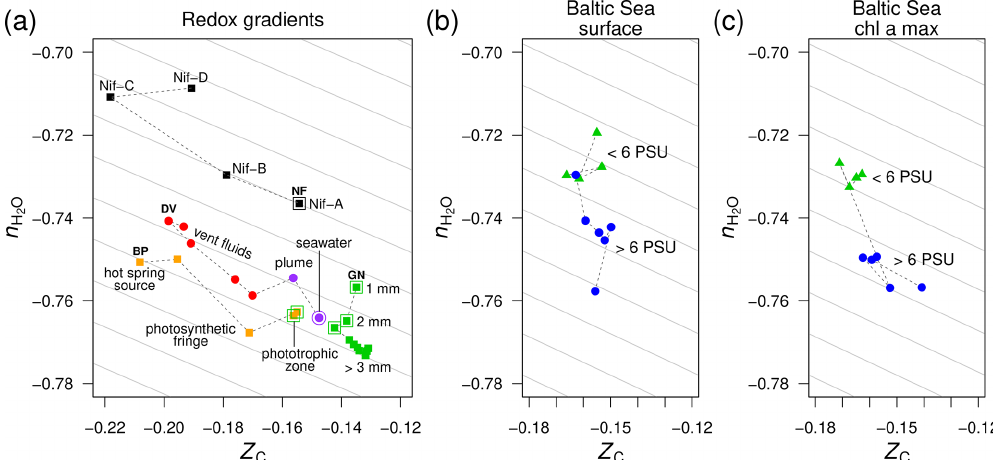
Figure 3. Compositional analysis of proteins in redox gradients and the Baltic Sea salinity gradient. (a) Redox gradients. Abbreviations and data sources: BP (Bison Pool hot spring; Havig et al., 2011; Swingley et al., 2012), DV (diffuse submarine vents; Reveillaud et al., 2016; Fortunato et al., 2018), GN (Guerrero Negro microbial mat; Kunin et al., 2008), and NF (nitrogenase-bearing organisms; Poudel et al., 2018). The NF data are based on reference proteomes (see Methods section); all others are for protein sequences predicted from metagenomic data. Outlined symbols indicate samples from relatively oxidizing conditions. (b) Surface and (c) deeper samples (Chl a max: chlorophyll a maximum, 9–30m deep) from the Baltic Sea transect. Metagenomes as described in Dupont et al. (2014) were downloaded from iMicrobe (Youens-Clark et al., 2019); the plots show data for the 0.1–0.8µm size fraction collected from stations along the transect at low salinity (<6PSU) and high salinity (>6PSU). Background guidelines have slopes equal to that of the n H – Z C linear regression for amino acids in 2 O Fig.